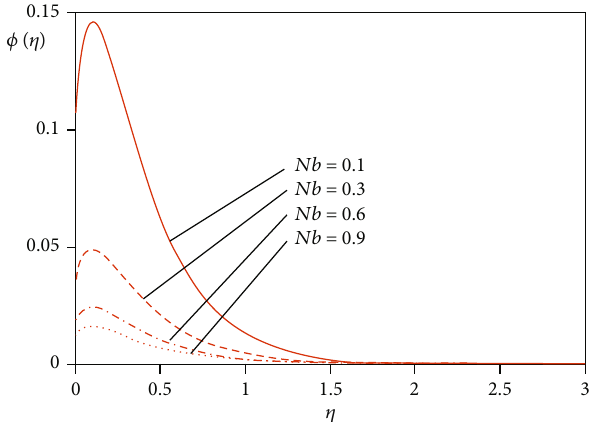
Figure 9: Concentration pro fi les a ff ected by Brownian motion